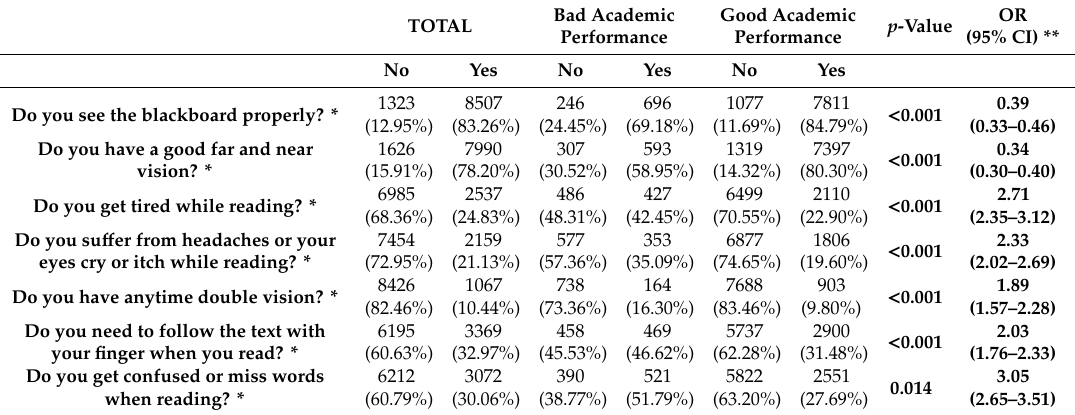
Table 2. Answers given by children about their vision in daily life